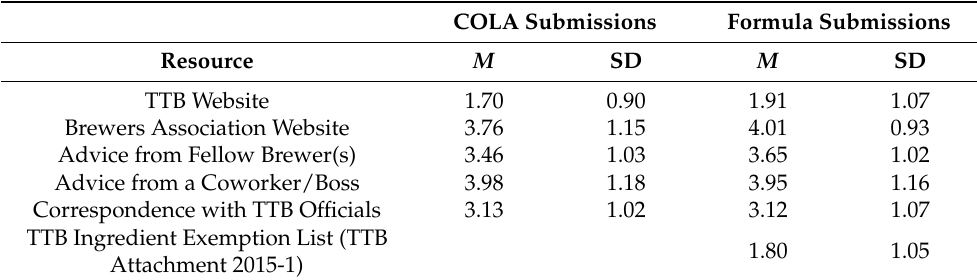
Table 5. Brewers’ Use of Labeling and Formula Resources During Submission Preparation.